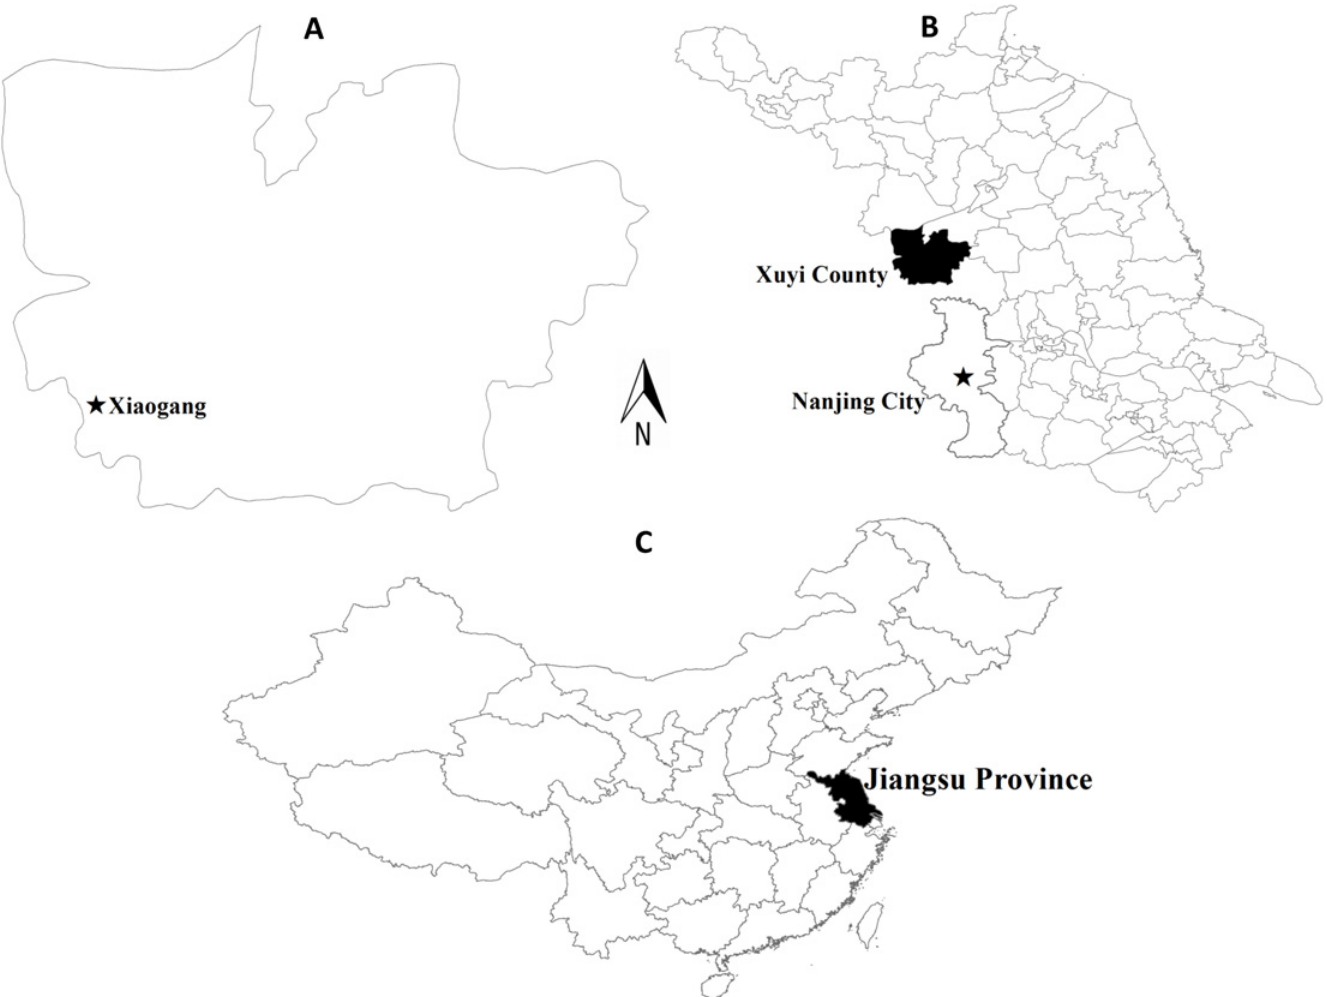
Fig 1. Location of the natural infection study site, Xiaogang village (indicated with a star in 1A) in Xuyi County, Jiangsu Province, China. Maps 1B and 1C show location of Xuyi County in Jiangsu Province and Jiangsu Province in China,